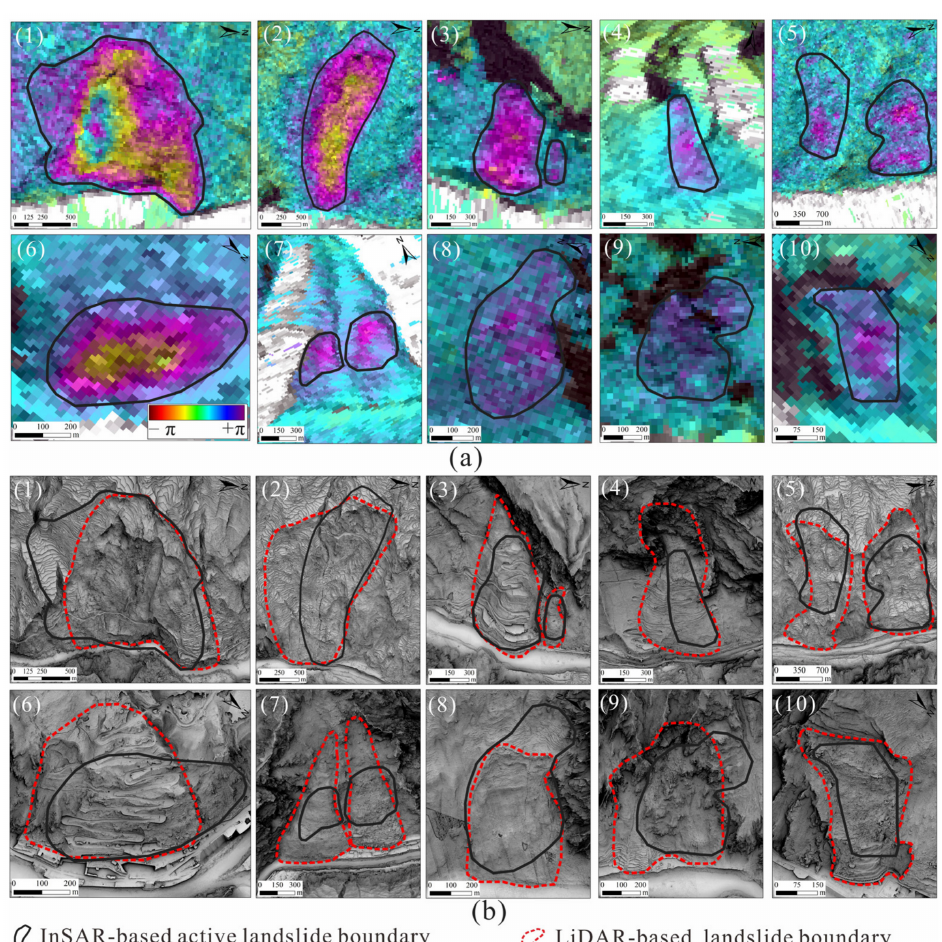
Figure 5. ( a ) Enlarged differential interferograms; and ( b ) DEM-derived SVF images of 10 exemplary landslides. The black solid lines and the red dotted lines indicate the boundaries of the InSAR-based and LiDAR-based landslides,